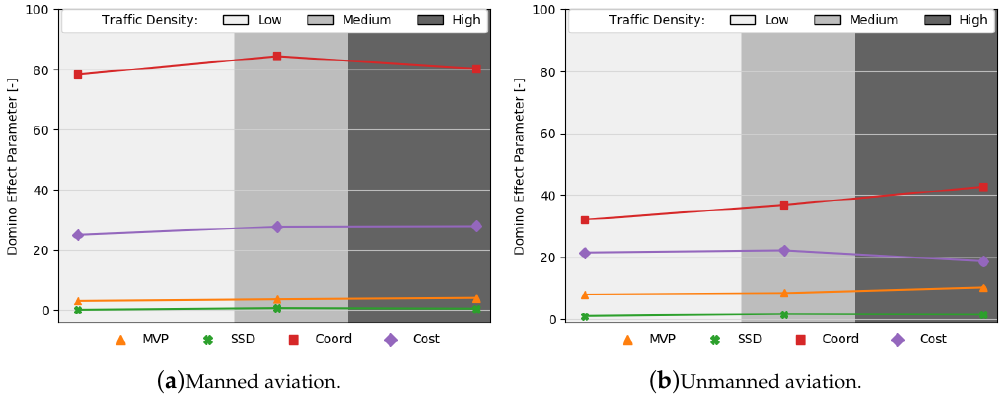
Figure 15. Domino effect parameter (DEP) per CD&R